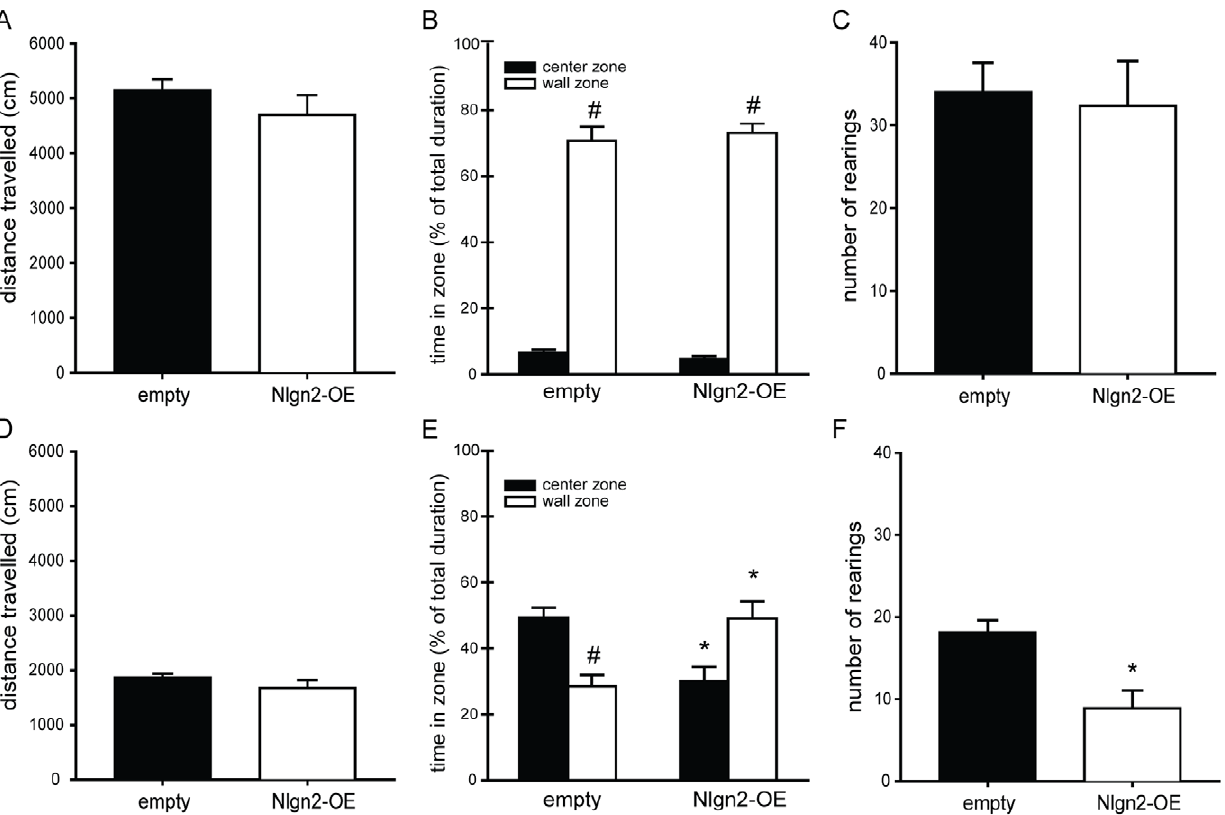
Figure 2. Open field-Novel object. A–C, Open field. A, Distance travelled in the open-field apparatus. No differences were observed concerning exploration between the groups (empty 5141.94 6 202.83, nlgn2-OE 4694.12 6 363.56, t-test ns). B, Time spent in zones of the open-field. All animals spent more time in the wall zone than in the center zone (paired t-test, empty p , 0.001, nlgn2-OE p , 0.001), but no difference between the groups could be found (F (1,17 )=0.461, p=0.506). C, Number of rearings. No differences between the groups (empty 34.0 6 3.56, nlgn2-OE 32.3 6 5.41, t-test ns). D–F Novel object. D, Distance travelled during the novel object trial. The groups did not differ in terms of travelled distance (empty 1864.98 6 72.31, nlgn2-OE 1676.04 6 147.7, t-test ns). E, Time spent in the zones during the NO trial. Empty virus control animals spent more time in the center exploring the object than in the wall zone (paired t-test, p , 0.01), whereas nlgn2-OE animals spent significantly less time in the center compared to empty virus animals (empty 49.41 6 2.86, nlgn2-OE 30.03 6 4.35, p , 0.001) and significantly more time in the wall zone compared to empty virus animals (empty 28.44 6 3.47, nlgn2-OE 49.06 6 5.18, p , 0.01). Nlgn2-OE rats showed a strong trend to spend more time in the wall zone compared to the center zone, but this effect did not reach significance (paired t-test, p=0.055). F, Number of rearings. Animals injected with the empty virus showed significantly more rearing during the NO trial compared to nlgn2-OE animals (empty 18.1 6 1.49, nlgn2-OE 8.9 6 2.16, p , 0.01). Empty n=10, Nlgn2-OE n=9. ns=Not significant. *significantly different from empty animals, # significantly different from center zone.